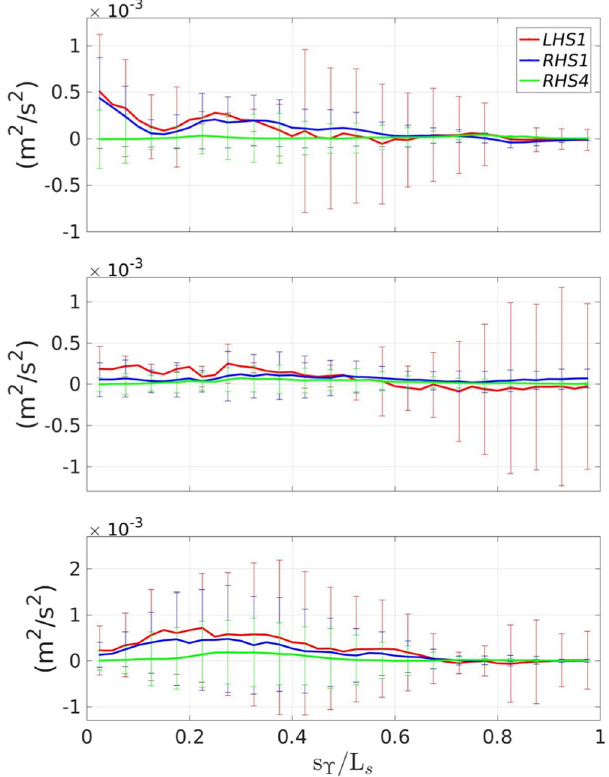
Figure 4. Comparison between the (1)  and ε ( ) 2  terms of equation 1 along the breaker. From top to bottom: ⁎ t , ⁎ t , ⁎ t t e g